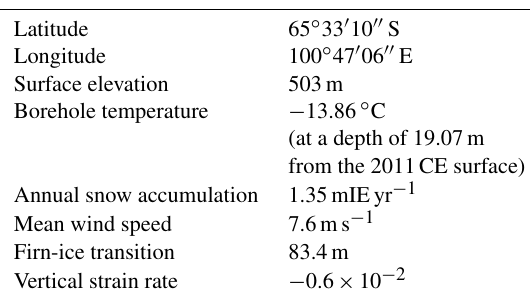
Table 1. General glaciology information of Mill Island ice core